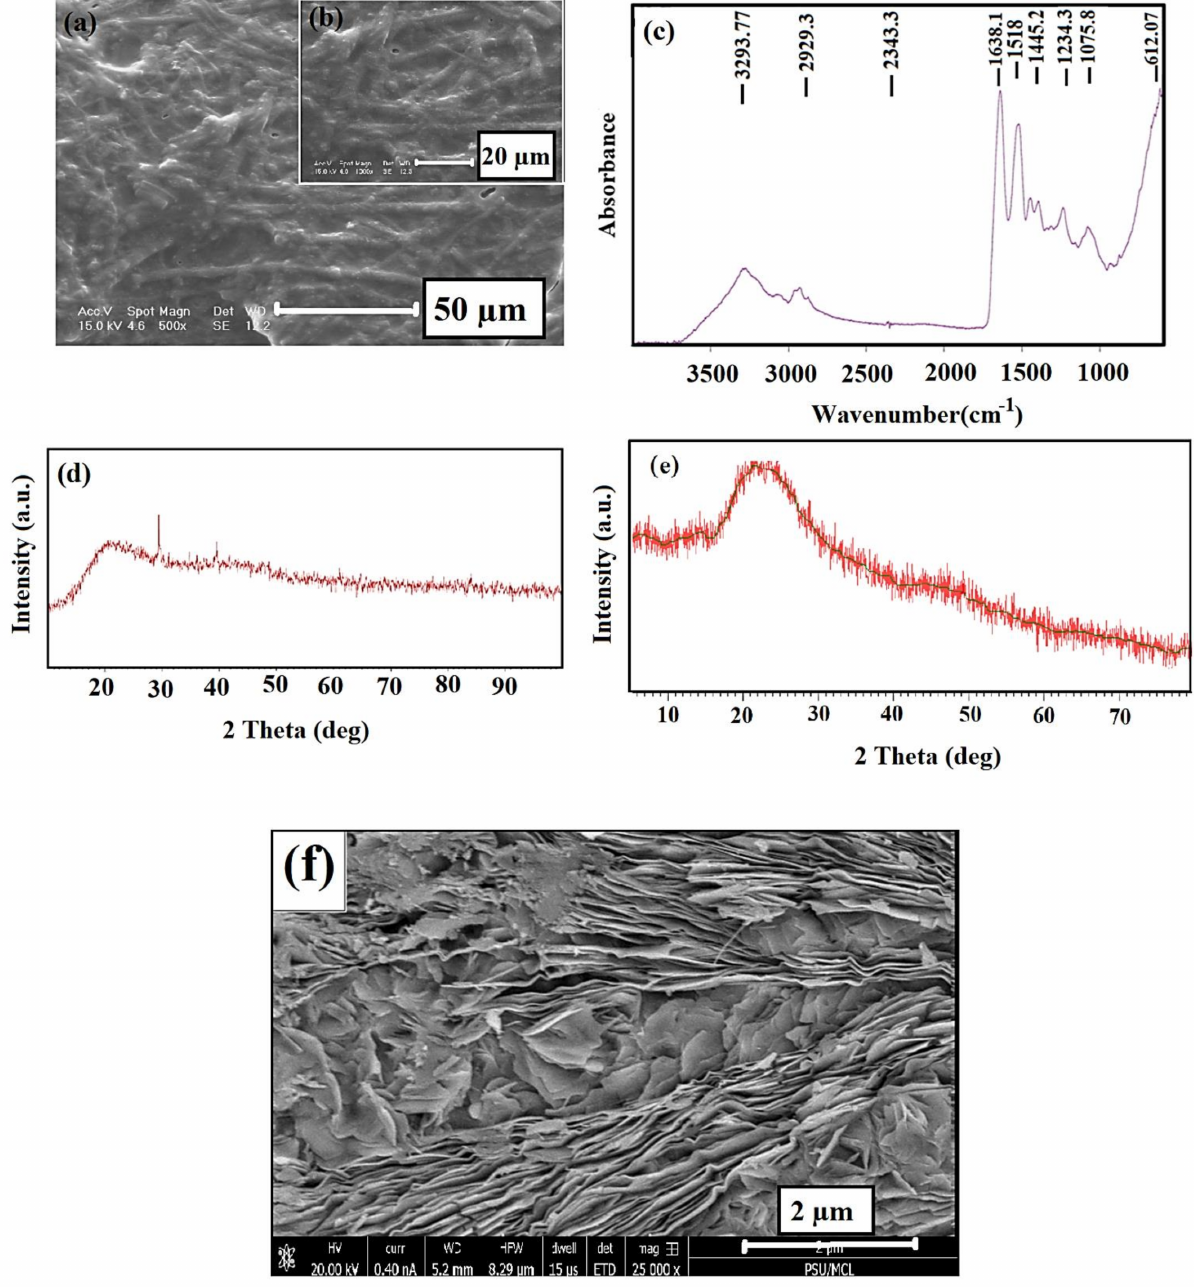
Figure 2. ( a , b ) SEM images, ( c ) FTIR spectra, ( d ) XRD pattern of eggshell membrane (ESM), ( e ) XRD pattern, and ( f ) FE–SEM images of